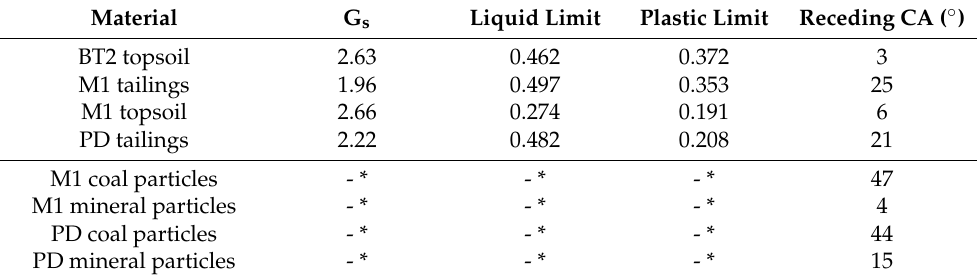
Table 1. Specific gravity (G s ), Atterberg limits (AS 1289.3.9.1 and AS 1289.3.2.1), and receding contact angle [37] measured for tailings, topsoils, and coal and mineral particles separated from each coal